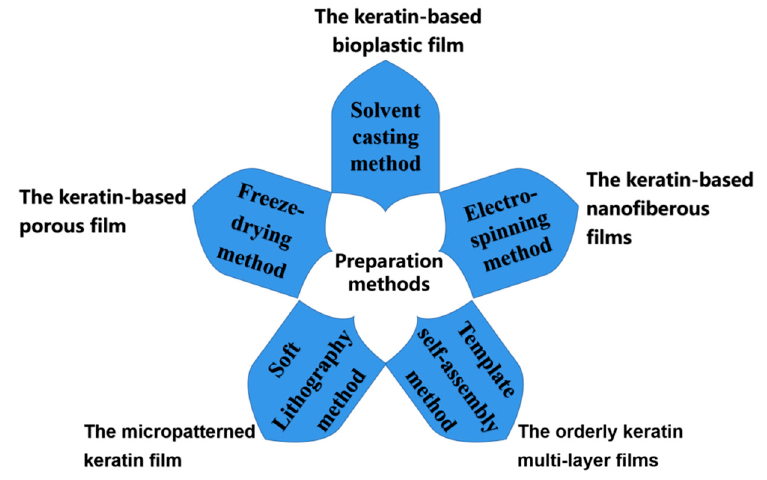
Figure 2. Keratin-based biofilm preparation methods.